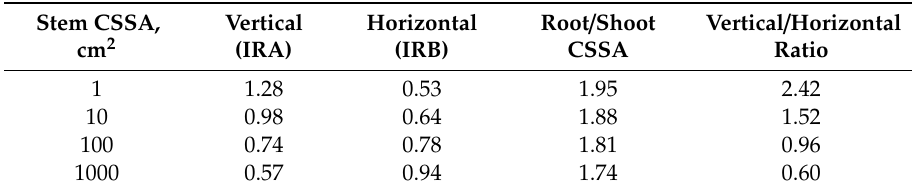
Table 3. Average impact of increasing stem diameter (and cross-sectional area, CSSA) on vertical and horizontal proximal root CSSA, based on regression equations in Figure 8.